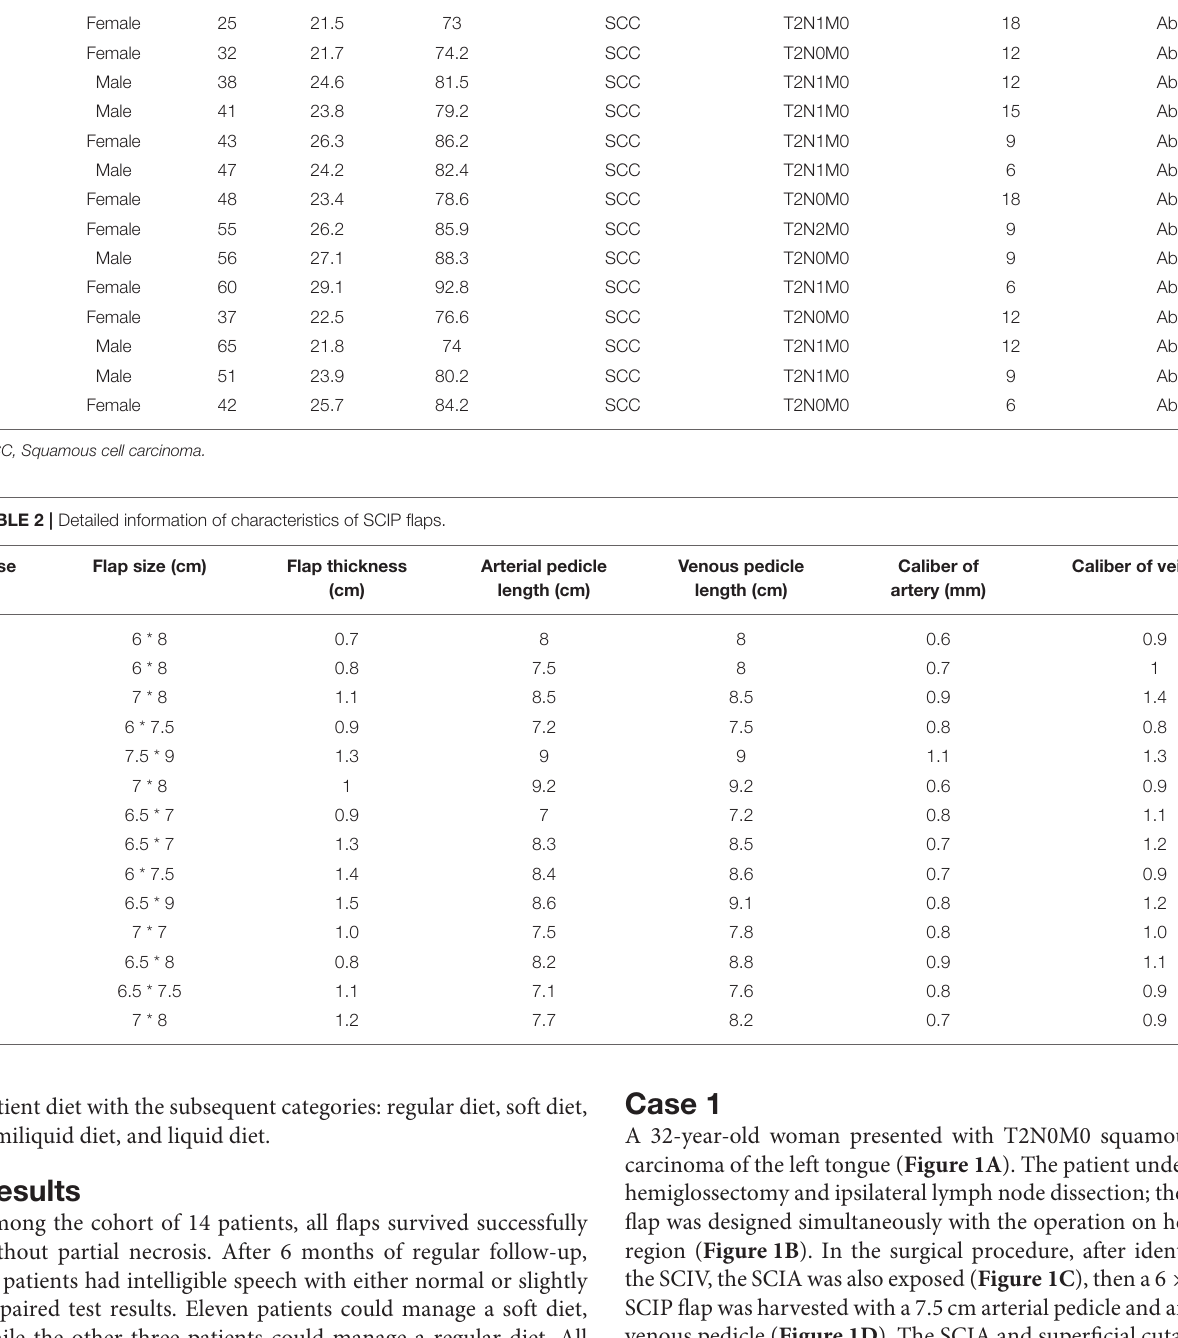
A 32-year-old woman presented with T2N0M0 squamous